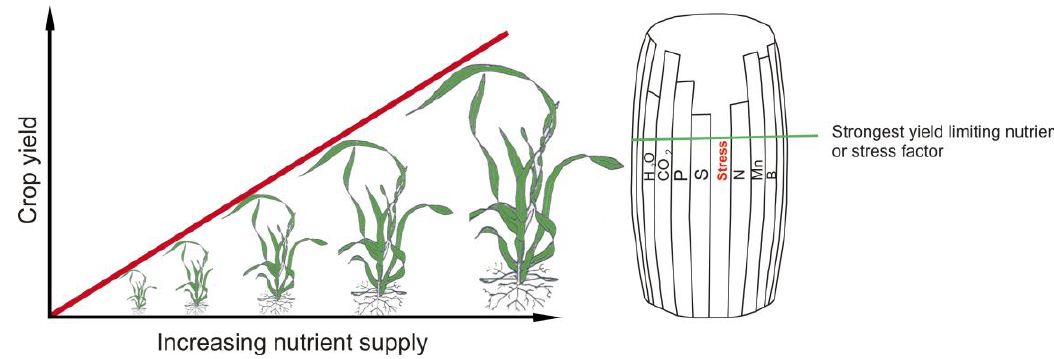
Figure 1. Liebig ’s law of the minimum (diagrammatic illustration).